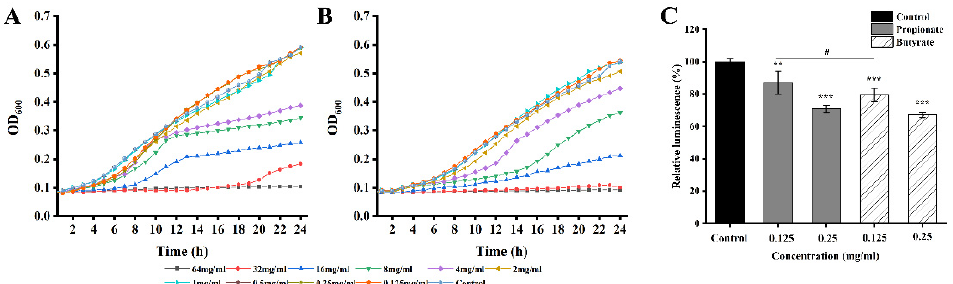
Figure 5. The growth curve of V. harveyi BB170 treated with different concentrations of ( A ) propionate and ( B ) butyrate, respectively. ( C ) The AI-2 production of S. Typhimurium SL1344. “**” and “***” indicates significance compared to the control. “ # ” indicates significance between different SCFAs treatments. “*” “ # ” p < 0.05, “**” p < 0.01, “***” p < 0.001.